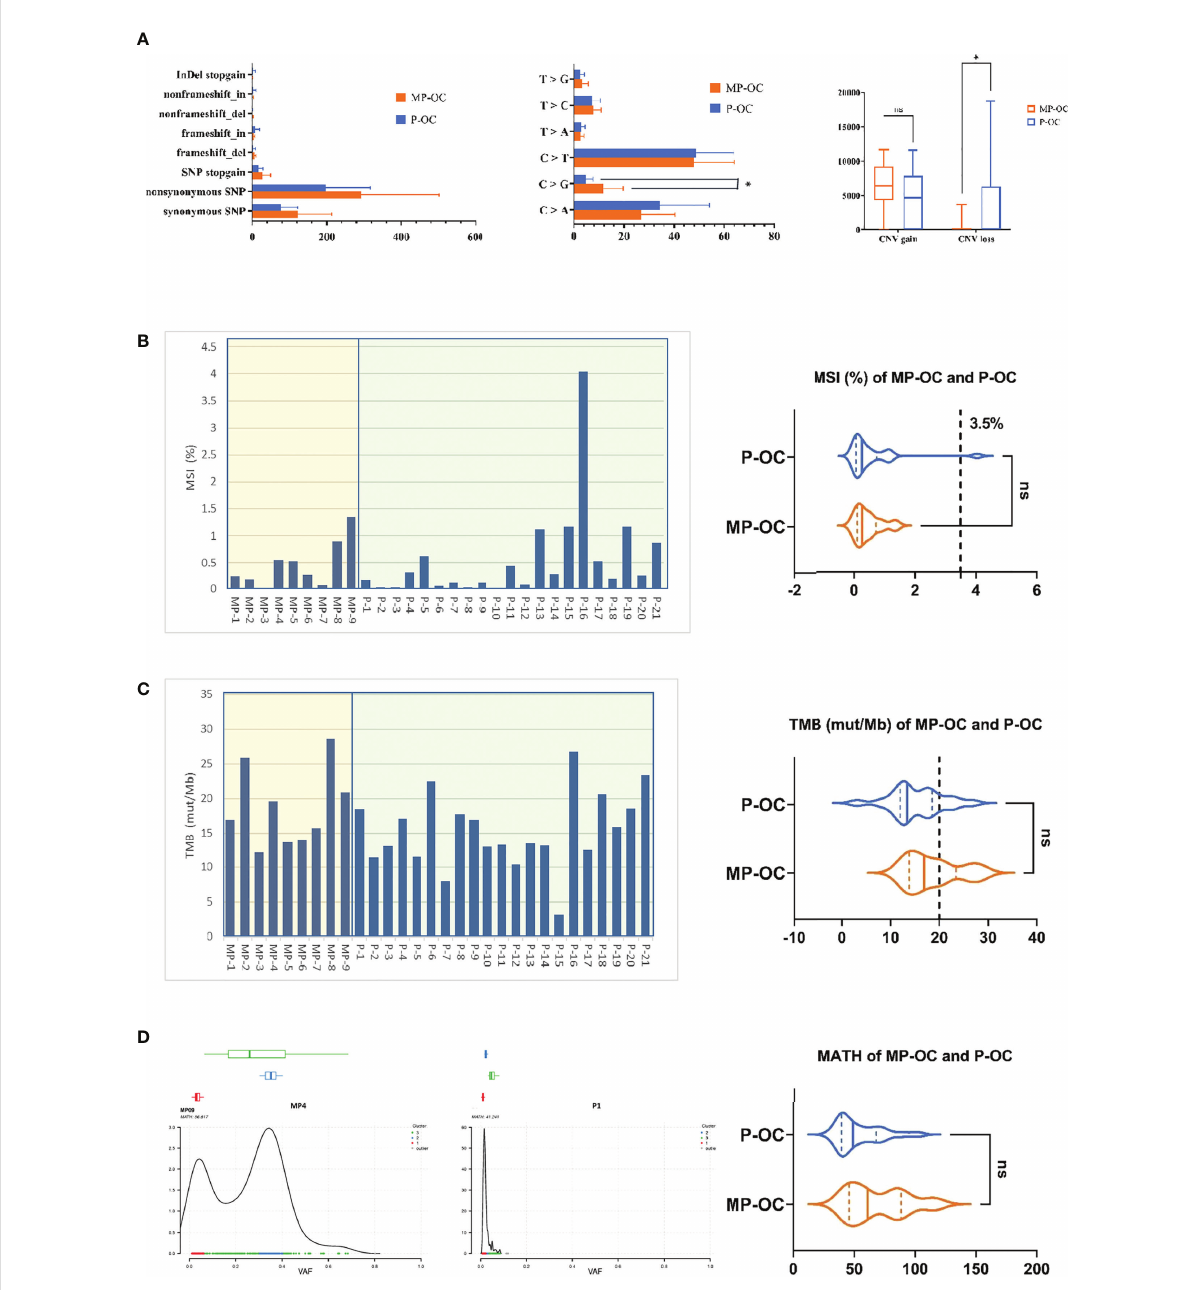
FIGURE 2 General mutation characteristics of 9 MP-OC and 21 P-OC patients. All somatic substitutions identi fi ed in this study were included, and the bar graph showed the subtype of SNP and InDel (left), proportion of base substitution types (middle), and number of copy number variation fragments (right) between MP-OC and P-OC groups, respectively. * indicates signi fi cant difference between the two groups (Mann – Whitney test, p < 0.05) (A) . TMB and MSI of 9 MP-OC patients and 21 P-OC patients. The bar chart (left) shows the details of 30 patients, and the violin diagram (right) shows the comparison of MSI and TMB between the two groups, respectively. Mann – Whitney test, ns stands for no signi fi cance, which indicates p > 0.05. The cutoff between TMB-H and TMB-L is 20%, and the cutoff between MSI and MSS is 3.5% (B, C) . The fi gures showing typical MATH of MP-OC (left) and P-OC (middle) patients, respectively. The right violin diagram showing the comparison of MATH between the two groups. Mann – Whitney test, ns indicates p > 0.05 (D)